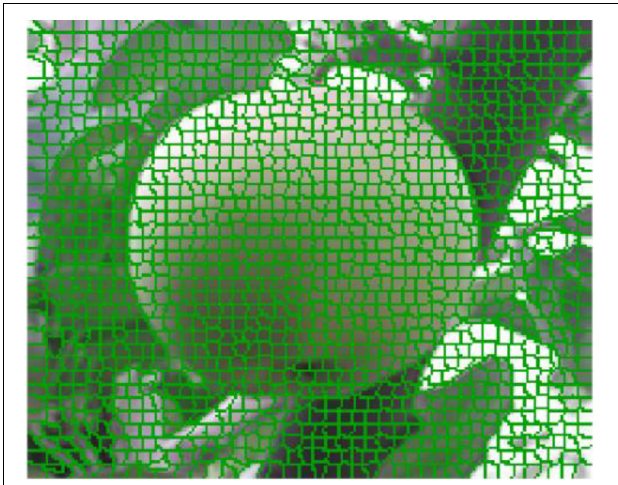
FIGURE 6 | SLIC super-pixel segmentation effect.